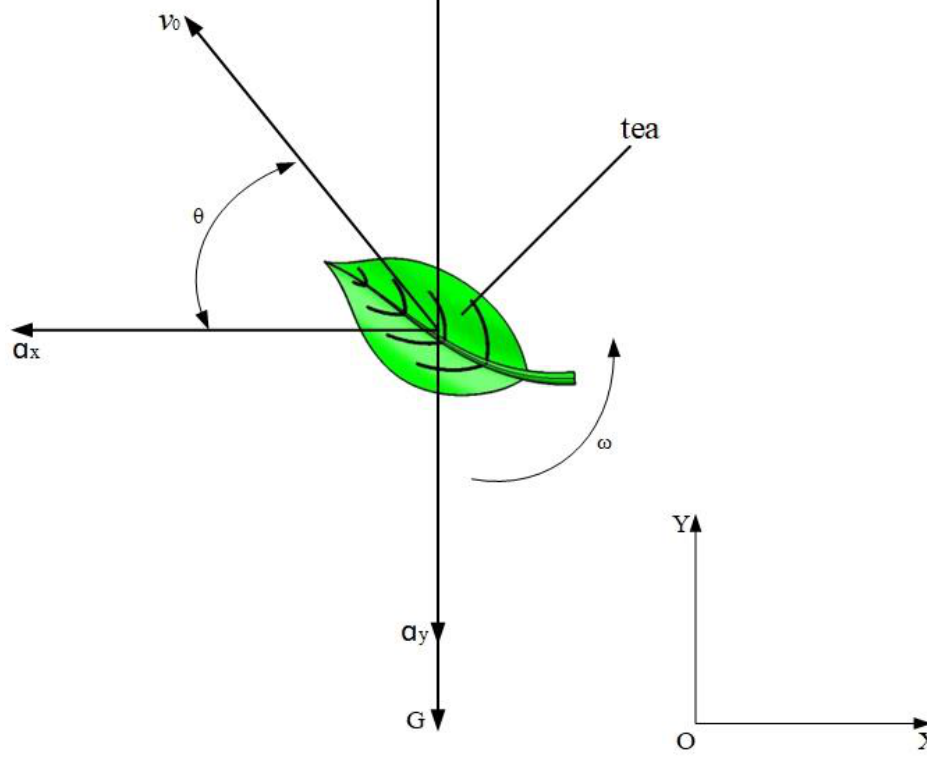
Figure 3. Force analysis diagram of tea particles for throwing motion.